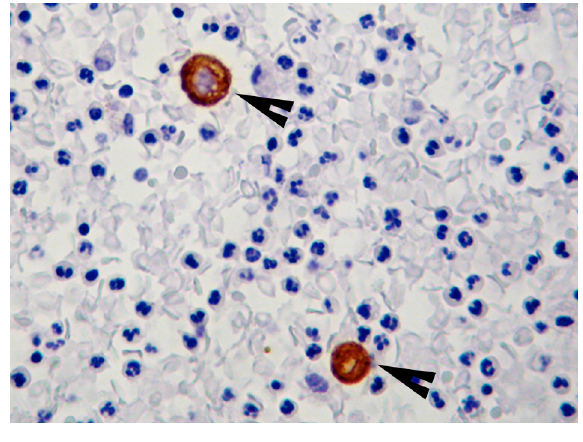
Figure 4. Immunohistochemical staining using the AE1/AE3 antibody, showing epithelial cells visualised as brown spots (arrowhead) (400x)